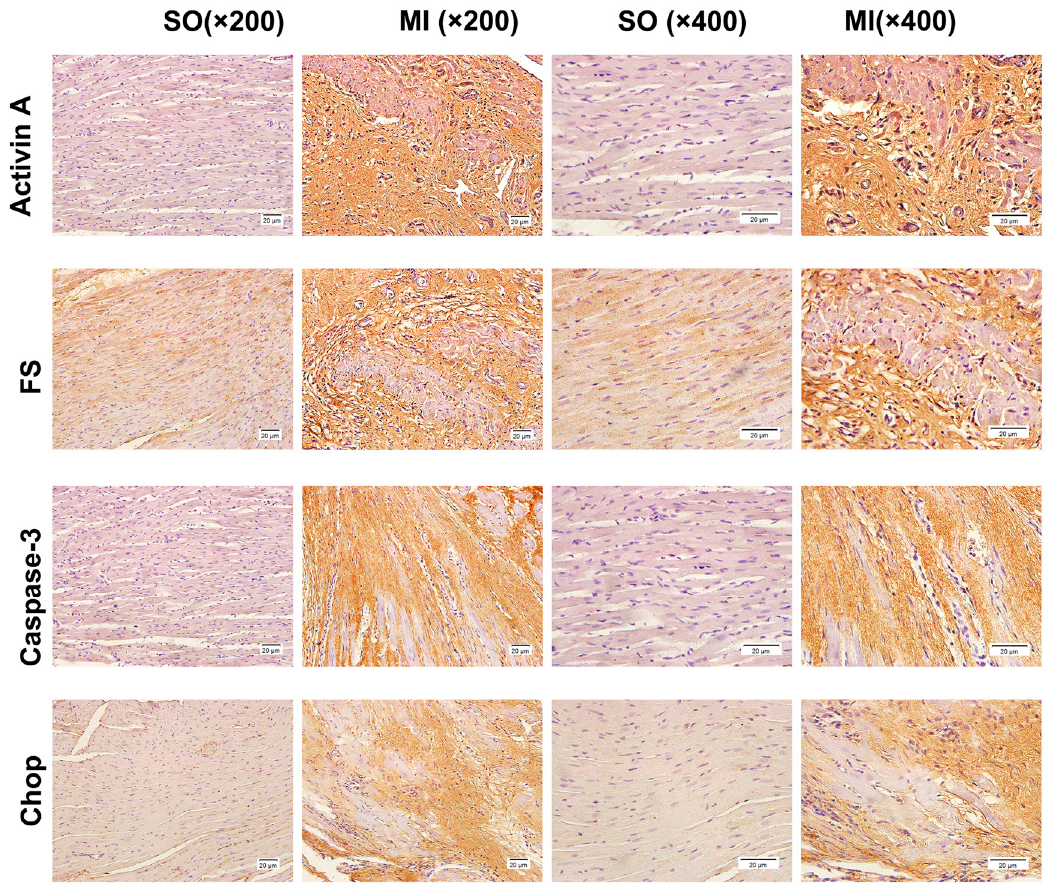
Figure 3. The expression of activin A, follistatin, caspase-3, and C/EBP homologous protein (CHOP) in rats detected by immunohistochemical staining. The border zones were used to take photos in the eight-week MI group. The expression of activin A, follistatin, caspase-3, and CHOP was detected using the anti-activin A antibody, anti-follistatin antibody, anti-caspase-3 antibody, and anti-CHOP antibody; IgG from a normal rabbit served as a negative control (200 × magnification and 400 × magnification).